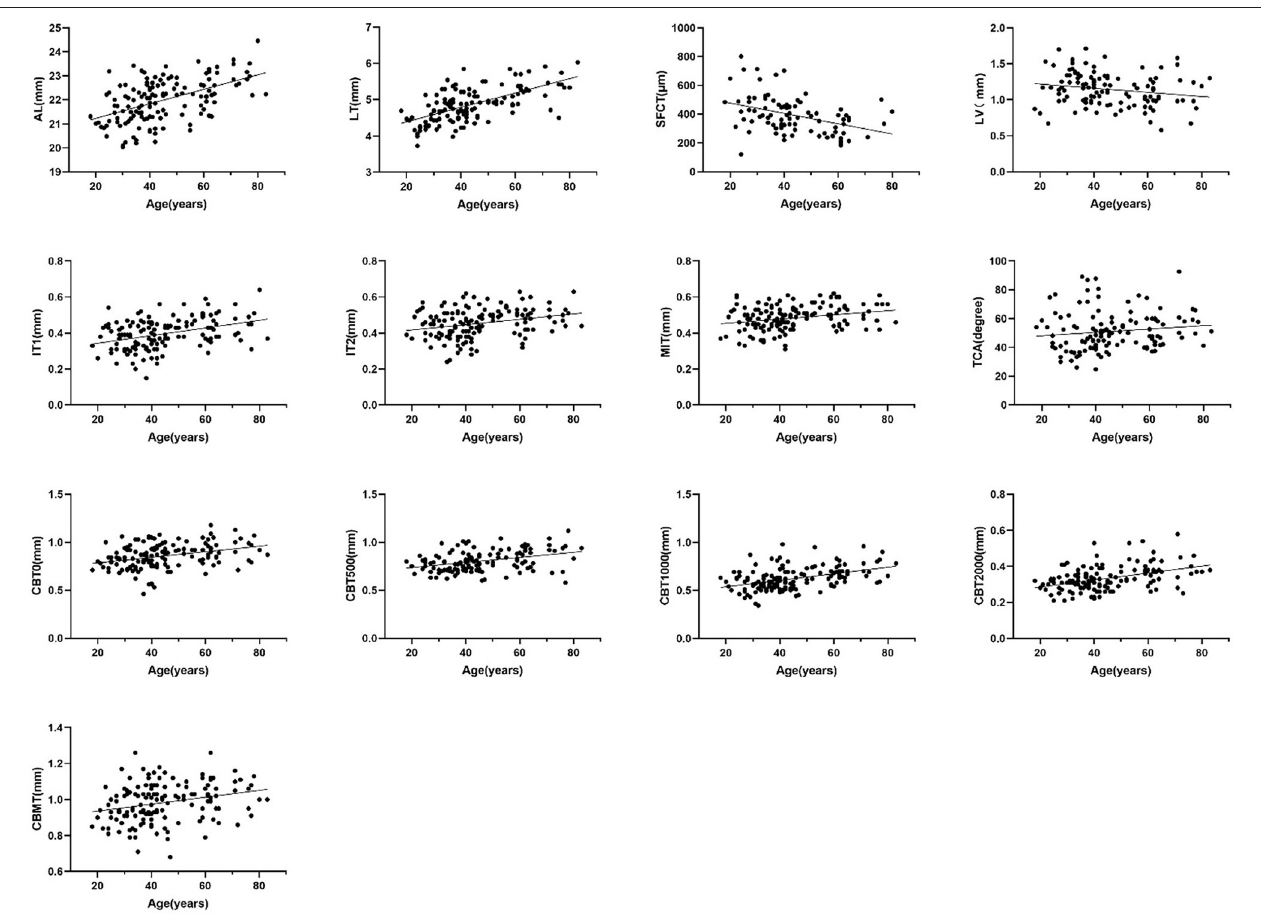
FIGURE 3 | Scatter diagram of the correlation between age and AL, LT, SFCT, LV, IT1, IT2, MIT, TCA, CBT00, CBT500, CBT1000, and CBMT (Spearman’s rank correlation, P < 0.05).